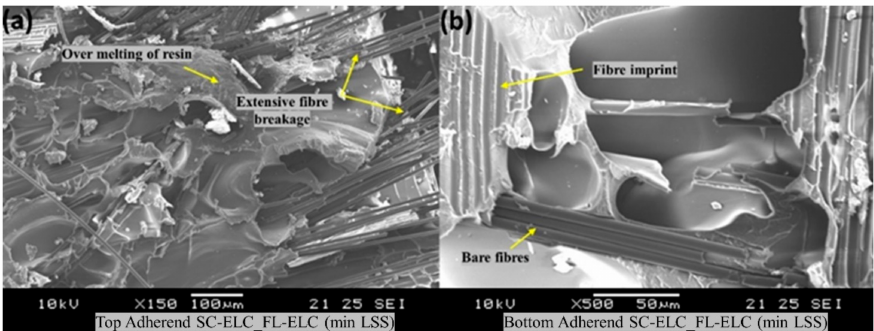
Figure 17. SEM fractography of the SC-ELC_FL-ELC composite for the minimum LSS.